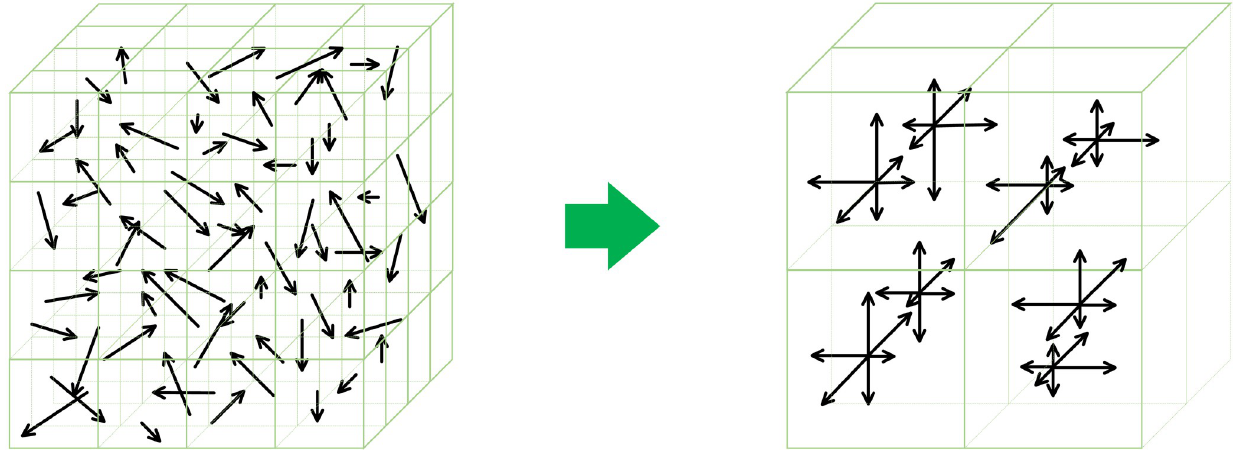
Fig 3. Illustration of 3D SIFT descriptors. The large arrow in the center points from a diagram showing the gradient distribution for a voxel’s 4 × 4 × 4 neighborhood to a diagram showing how the distribution fits into eight 2 × 2 × 2 sub-blocks with 6 directions/histogram bins.